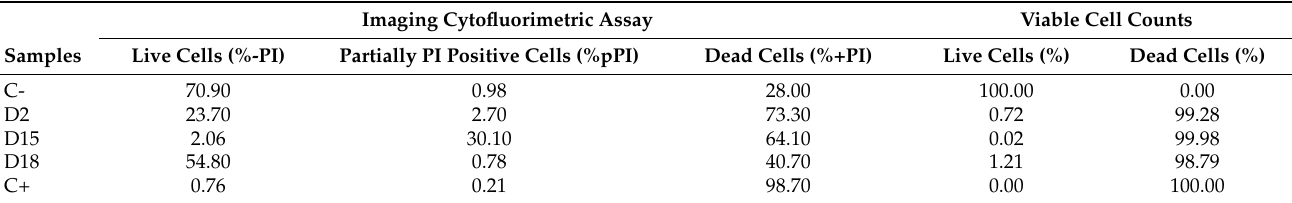
Figure 3. Imaging Cytofluorimetric assay. The images represent the distribution of the B. bruxellensis population in live cells (-PI gate), partially PI positive (pPI gate) and dead cells (+PI), after 96 h of incubation with 1 mg/mL of each D2 ( a ), D15 ( b ) and D18 ( c ). Negative control with live cells without any killer toxin ( d ). Positive control with ethanol-killed cells ( e ). Table 3. B. bruxellensis viability, detected with imaging cytofluorimetric assay and by viable cell counts, after 96 h of incubation with each killer toxin (1 mg/mL). The population of the sensitive yeast strain was represented as live, dead and partially PI positive cells for imaging cytofluorimetric assay, while the same populations were represented as relative percentage of live and dead cells by viable cell counts. C- represents the negative control where any toxins was added; C+ represents the positive control where the cells were killed with a treatment with 80% ethanol for 2